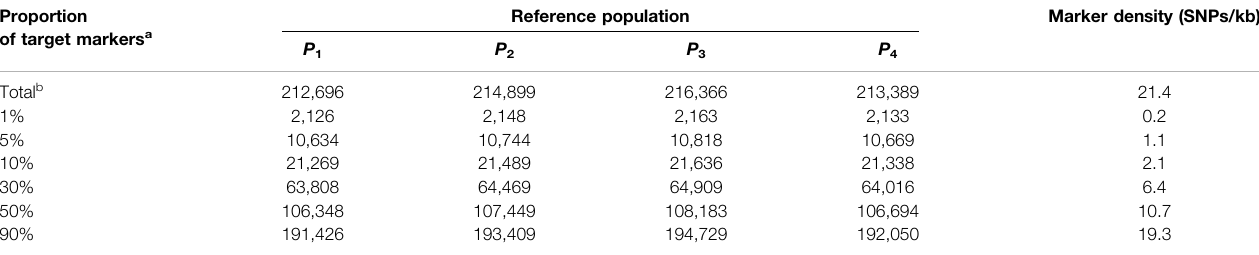
TABLE 4 | Number of segregating genetic variants in four simulated populations.